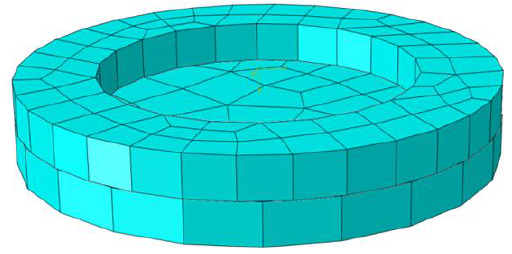
Figure 24. Numerical model of interface.